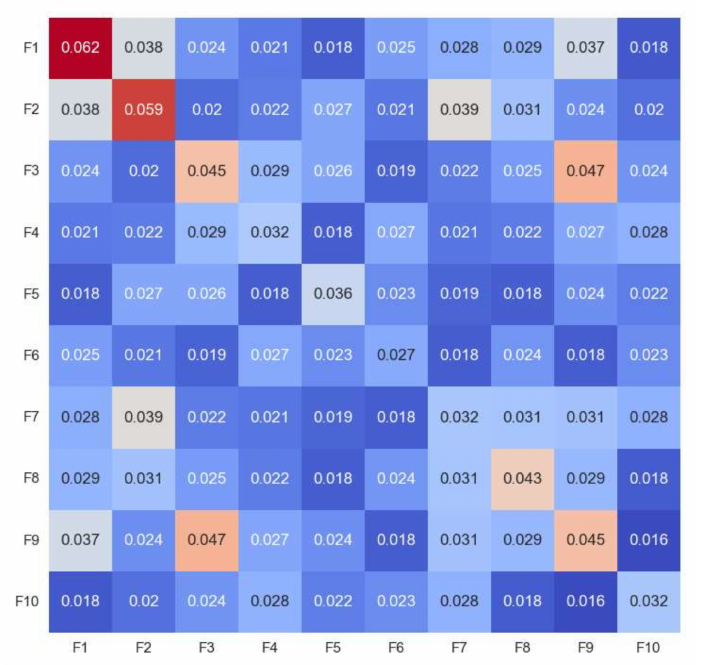
Figure 14. Contribution of features to a specific class depending on a threshold level.